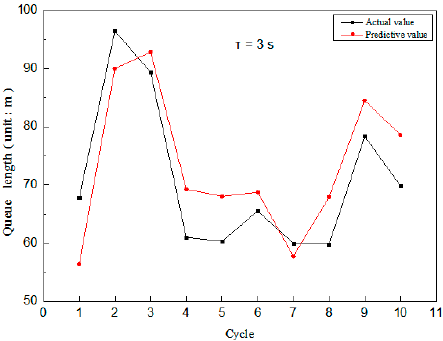
Figure 7. Schematic diagram of model prediction results based on DNN.